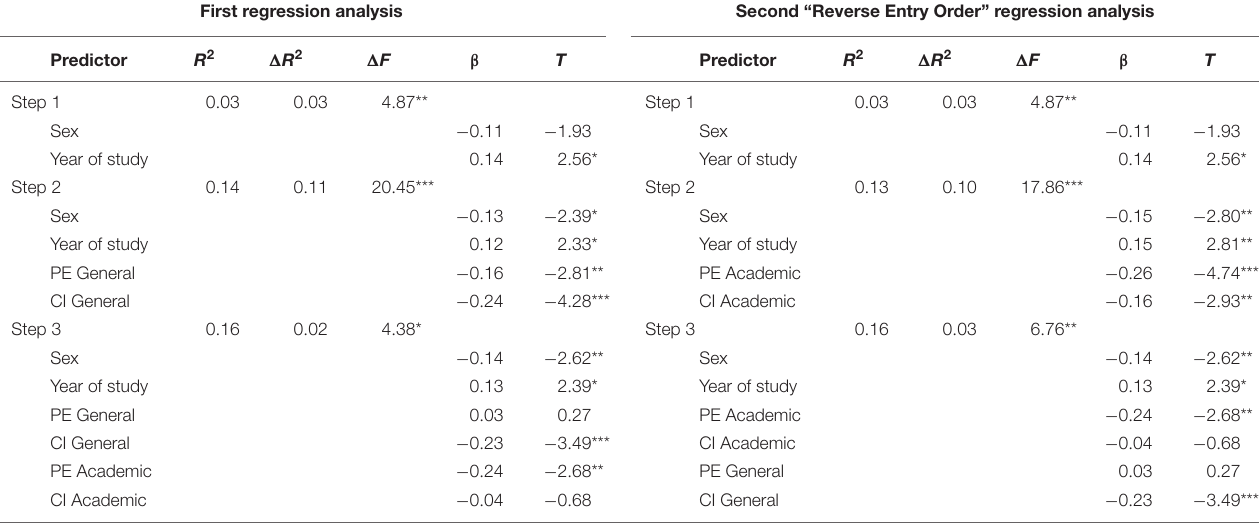
TABLE 4 | Two multiple regression analyses predicting emotional exhaustion in academic